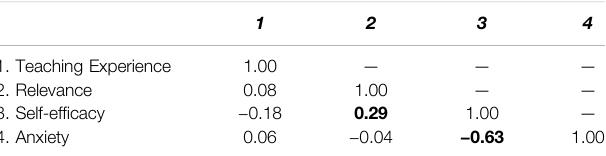
TABLE 2 | Correlations between the four scales used for clustering, derived from the pretest.